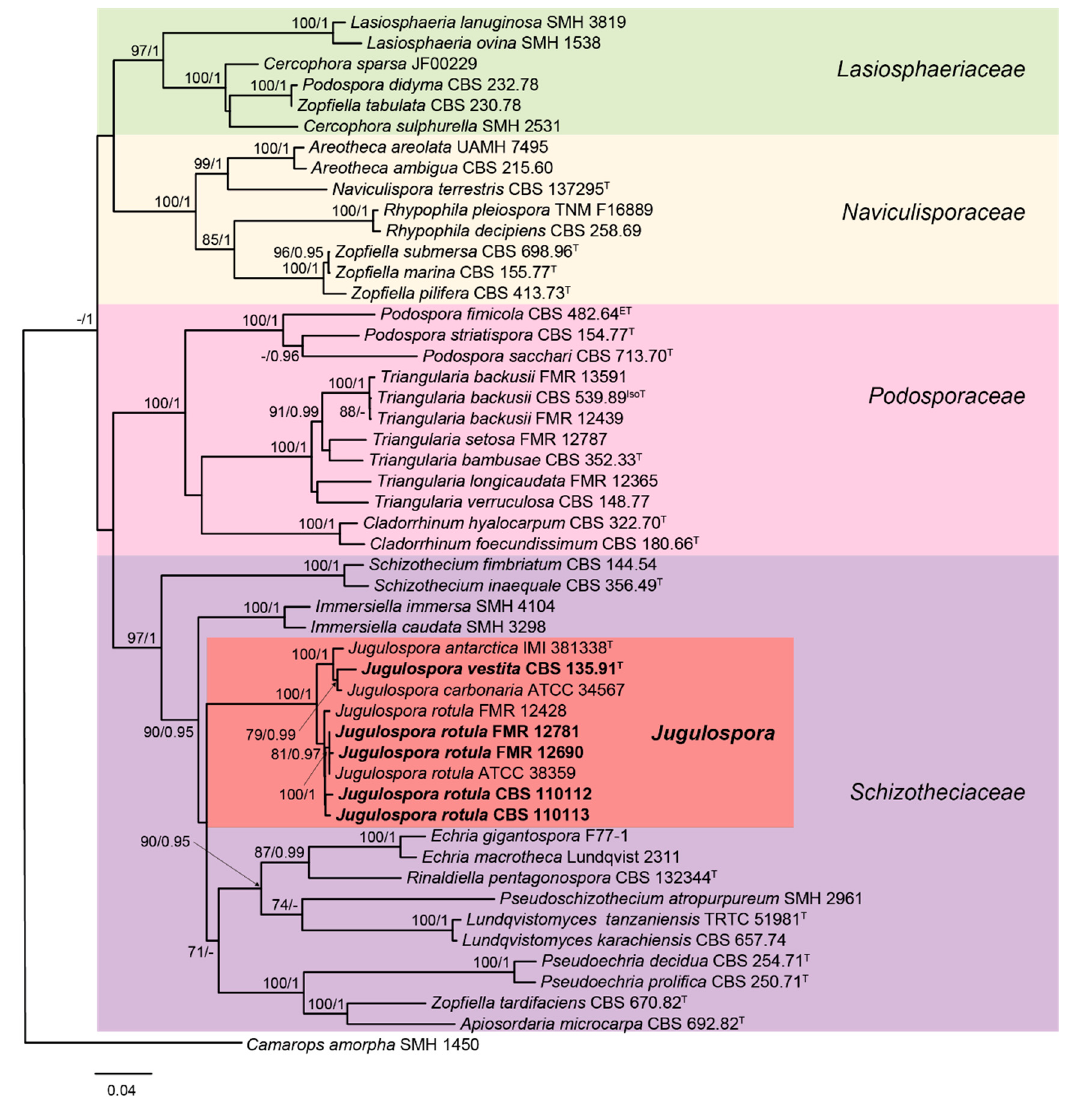
Figure 4. Randomized Axelerated Maximum Likelihood (RAxML) phylogram obtained from the combined sequences of the internal transcribed spacer region (ITS), the nuclear rDNA large subunit (LSU), and fragments of ribosomal polymerase II subunit 2 ( rpb2 ) and β -tubulin ( tub2 ) genes of selected strains belonging to the families Lasiosphaeriaceae, Naviculisporaceae, Podosporaceae, and Schizotheciaceae. Camarops amorpha SMH 1450 was used as an outgroup. Bootstrap support values ≥ 70 / Bayesian posterior probability scores ≥ 0.95 are indicated along branches. Branch lengths are proportional to distance. Screened taxa in the present study are in bold . Ex-epitype, ex-isotype, and ex-type strains of the different species are indicated with ET , IsoT , and T , respectively. GenBank accession numbers were indicated in Marin-Felix et al. [14], as well as the methodology followed for performing the phylogenetic study. The major clades are marked in different colors for the sake of better readability.